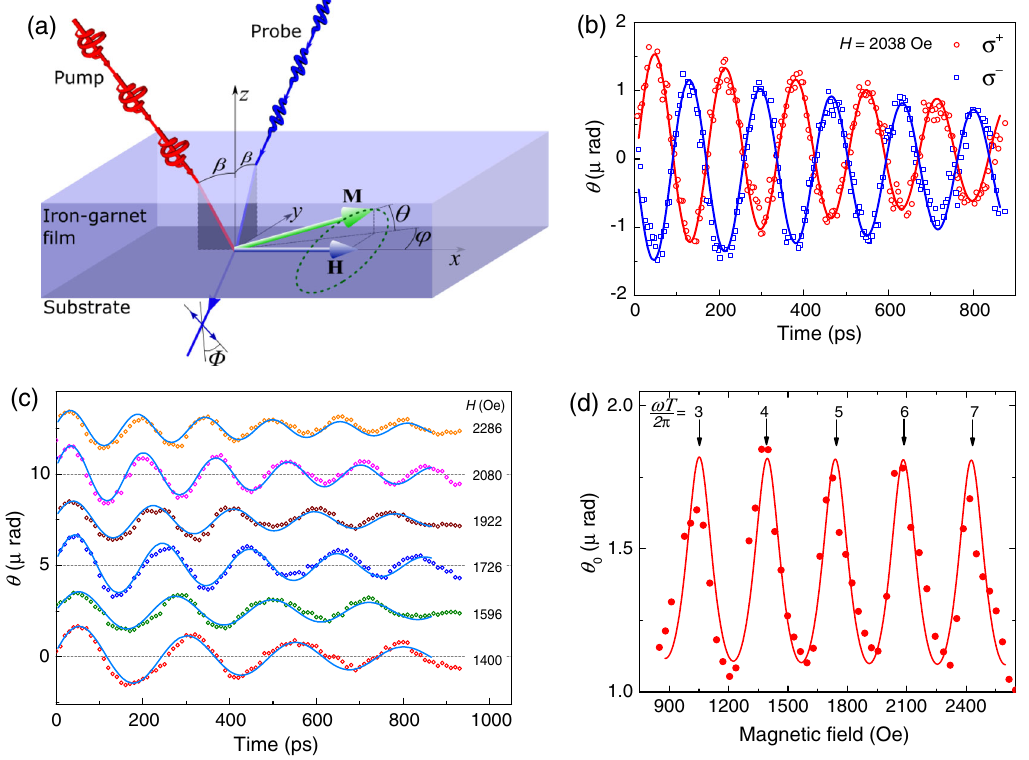
FIG. 1. Excitation of magnetization precession in an iron-garnet film by a train of fs optical pulses. (a) Experimental scheme. The periodic laser pulses are incident on the magnetic film. The probe beam is detected from the substrate side of the sample. (b) С omparison of magnetization oscillations excited by σ þ and σ − circularly polarized pumps (red circles and blue squares, respectively). Solid curves are fits with a decaying sine function. The fit parameters are given in Table SI (see Ref. [30]), H ¼ 2038 Oe. (c) Magnetization oscillations at different magnetic fields (open symbols) corresponding to maximal and minimal amplitudes. Fits to the data by decaying sines are given by the thin blue curves. The incident light is σ þ polarized. Fit parameters are given in Table SII (see Ref. [30]). (d) Measured precession amplitude vs magnetic field strength (circles). The solid curve is calculated after Eq. (3) using the parameters h ¼ 6 . 2 Oe, α ¼ 0 . 02 ( τ ¼ 0 . 77 ns at H ¼ 1500 Oe) to fit the experimental data. Experimental results are presented for sample